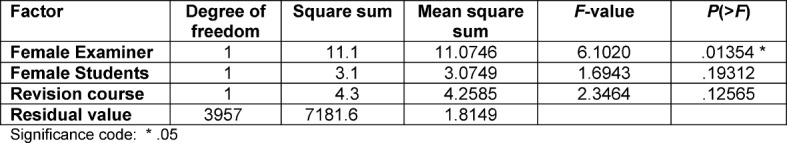
Multifactorial analysis of variance of grading.